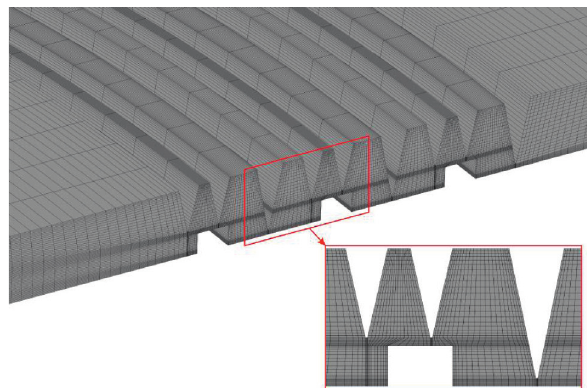
Figure 3: Grid distribution.